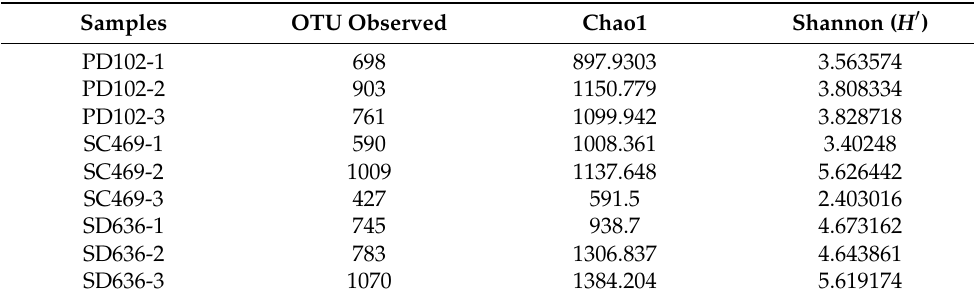
Table 6. Diversity statistics from each batch culture.